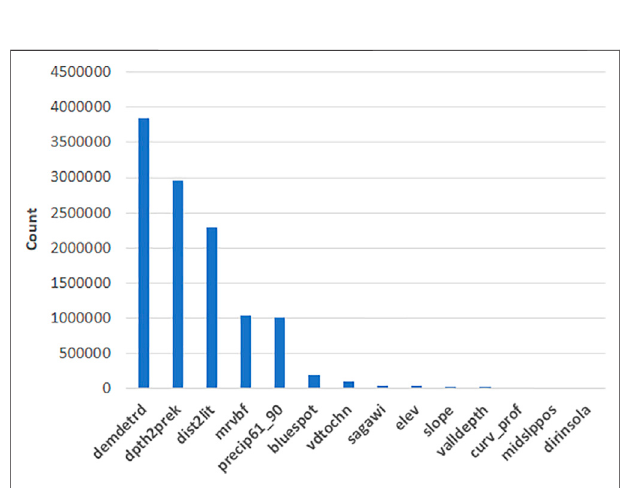
FIGURE 6 | Distribution of covariates with the largest SHAP importance for each patch (clari fi cation of covariate names in Table 1 ).